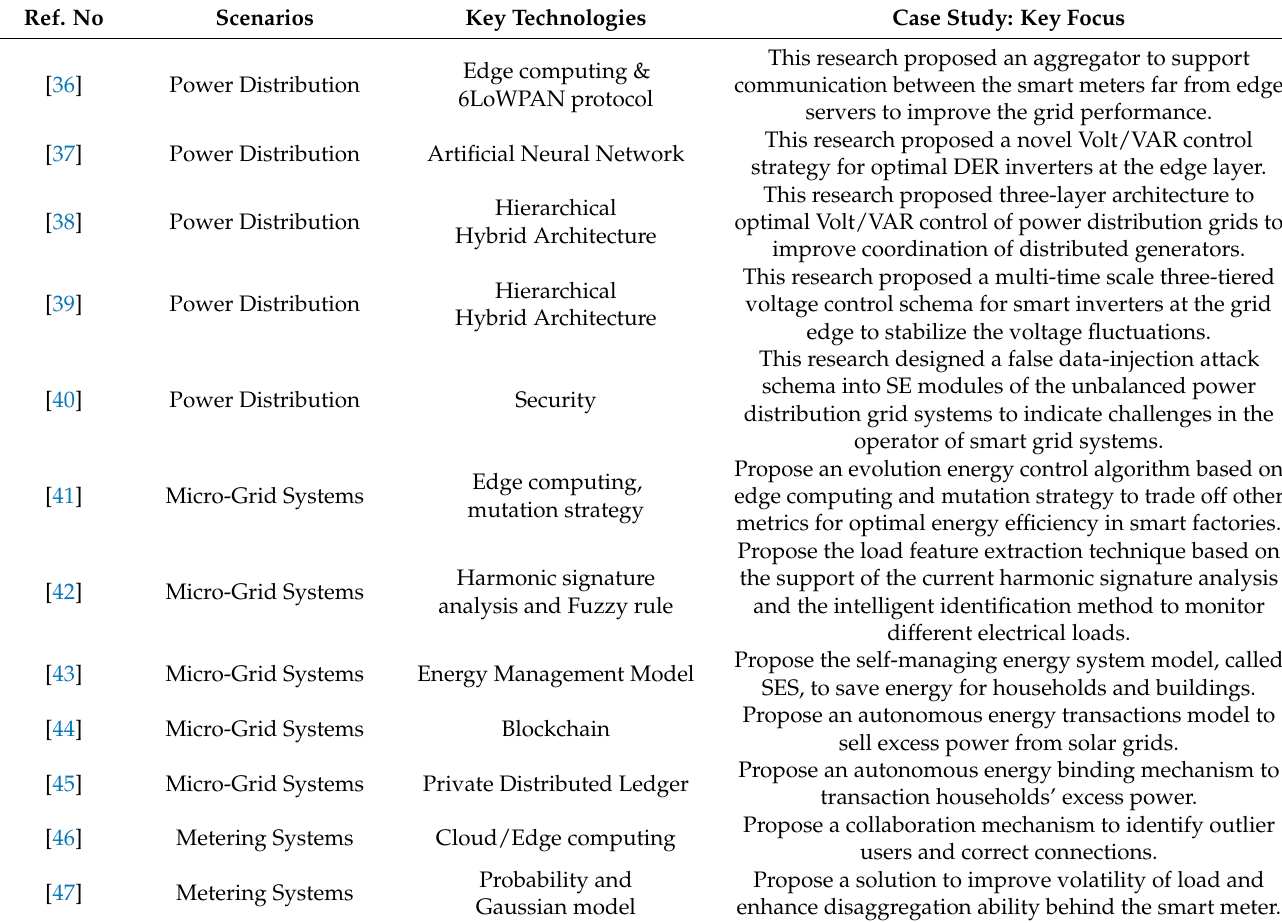
Table 1. Statistics of recently proposed EC–IoT-based SG